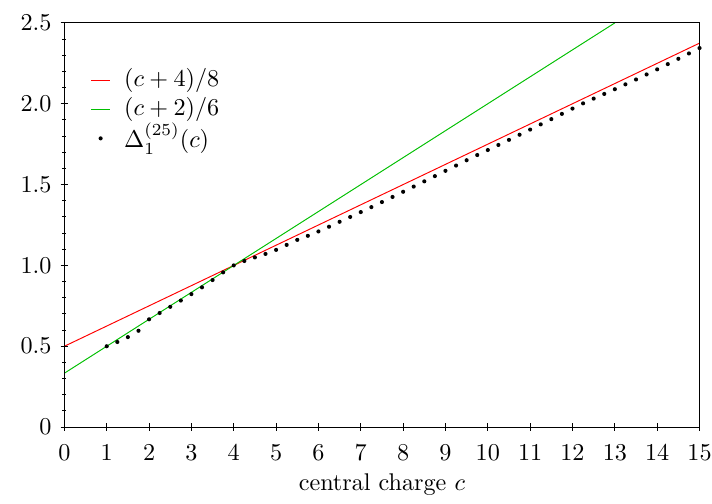
Figure 1 . Upper bound on ∆ 1 from the spinning modular bootstrap, at truncation order K = 25 .